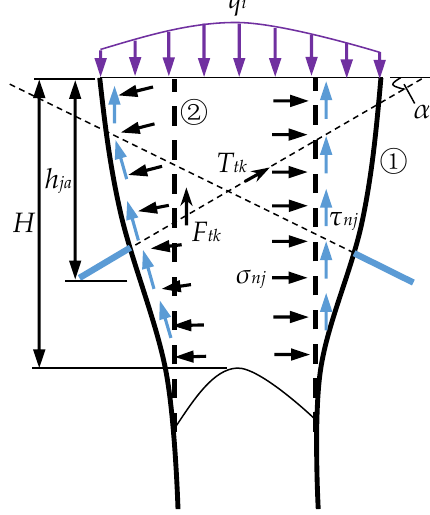
Figure 2. Mechanical models of shear failure of a plugging structure.